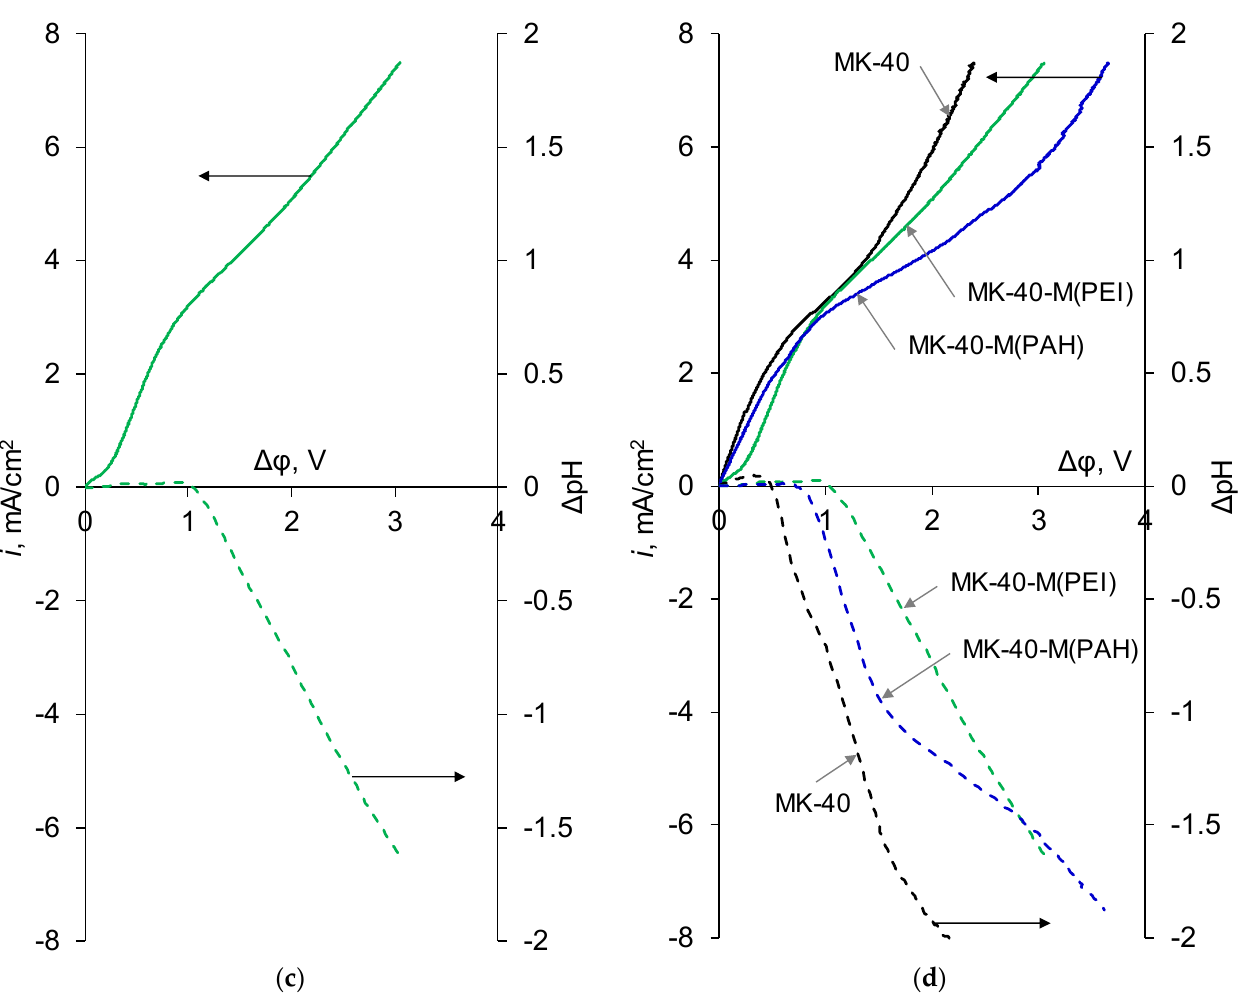
Figure 5. i ‐ V curves recorded before electrodialysis of ( a ) MK ‐ 40, ( b ) MK ‐ 40 ‐ M (PAH) and ( c ) MK ‐ 40 ‐ M (PEI) membranes, as well as the pH difference between the output and the input into the desalination channel formed by the studied membrane and the auxiliary MA ‐ 41 anion exchange membrane. Panel ( d ) shows a comparison of all curves. Solid lines are i ‐ V curves and dashed lines are pH curves.